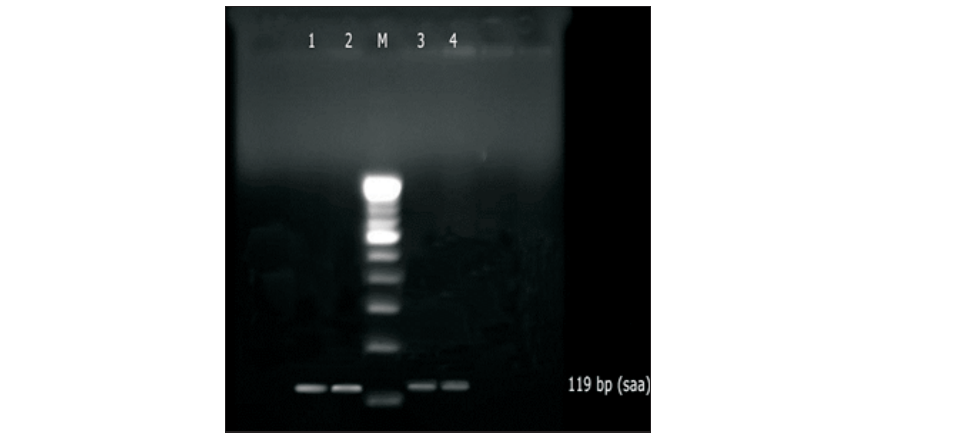
Figure-1: gene specific PCR analysis of STEC isolates. Lane 1: positive, Lane 2: positive, Lane M: Marker (100bp), Lane samples from sheep. In every case, it was associated with , and genes. Liu [21] could not detect any gene from 206 isolates obtained from suckling pigs with diarrhea in China. Prevalence of gene in buffalo was 8% [22] and 83% [23].